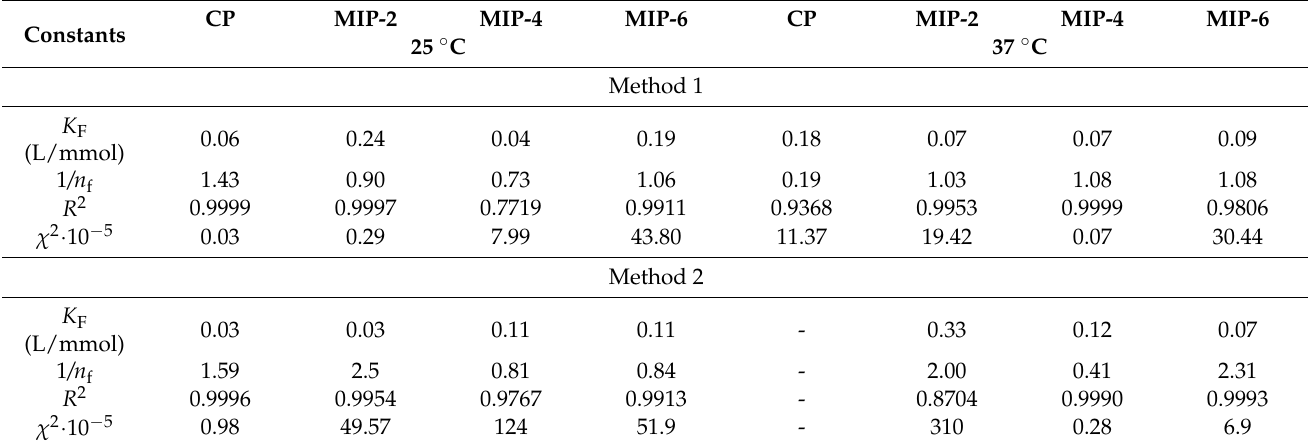
Table 4. Sorption constants calculated using the Freundlich model isotherm by the nonlinear regres- sion method (Method 1 and Method